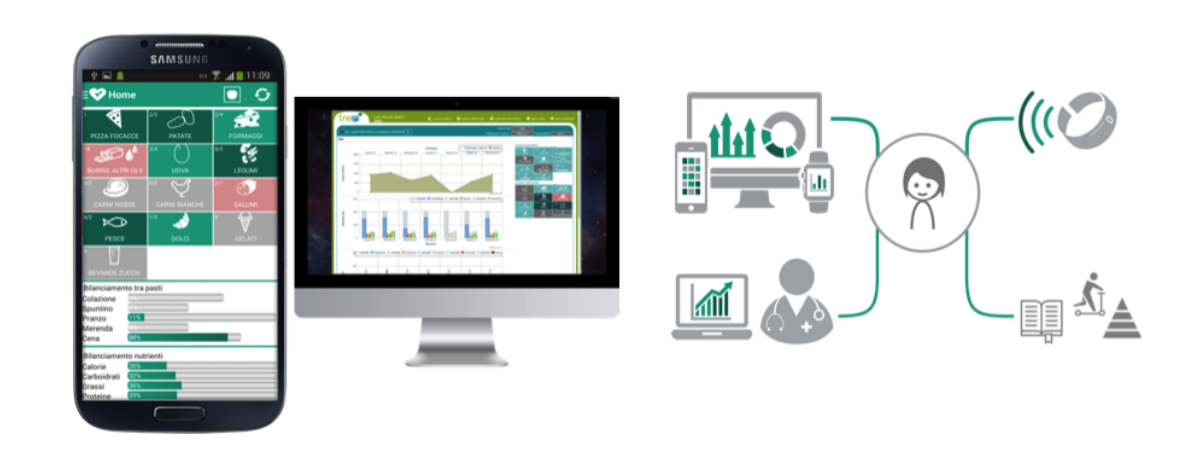
Figure 2. The TreC-LifeStyle mobile and Web platform.